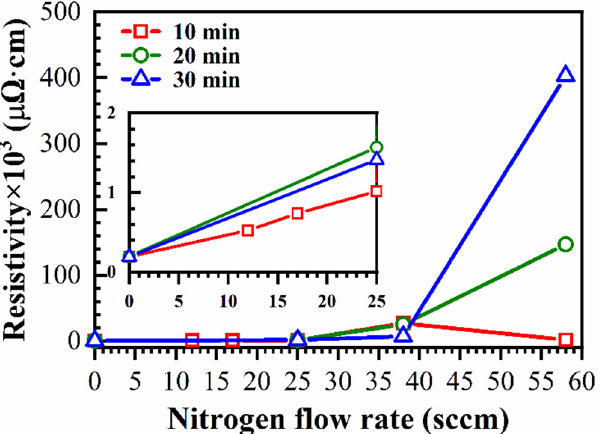
Figure 2. The resistivity TaN films at different nitrogen flow. The embedded graph is a zoom of data corresponding to the low nitrogen flow region.